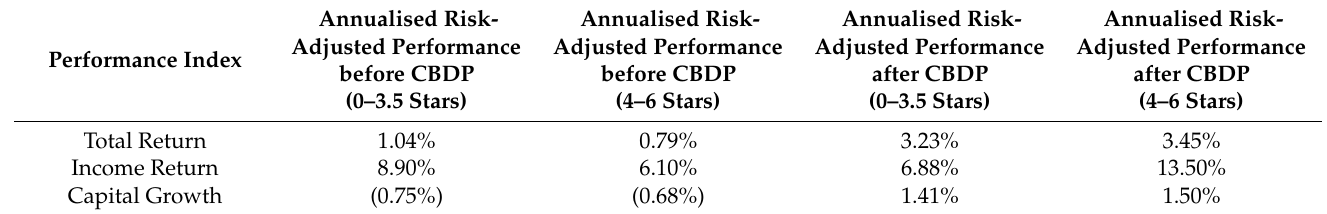
Table 6. Secondary market—risk-adjusted performance non-green (0–3.5 stars) vs. green (4–6